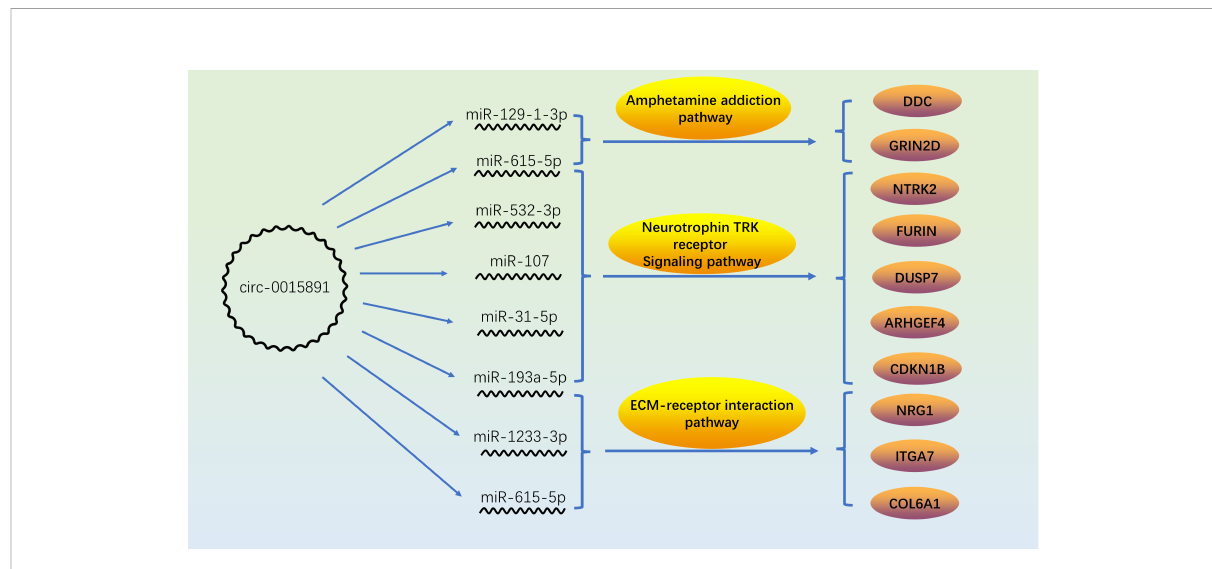
FIGURE 7 Role and correlation of circ_0015891/miRNAs/proteins in METH-related